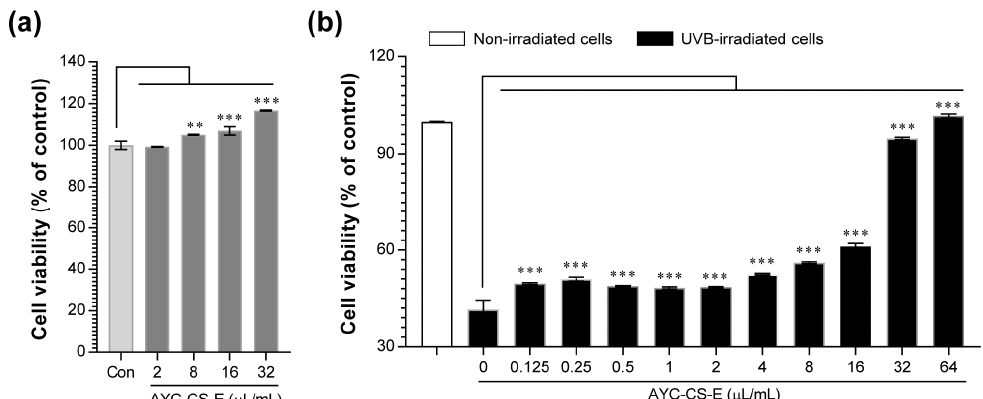
described in the Materials and Methods section. The cell viability for each condition was measured using the MTT assay. All bar graphs show the means ± standard deviation (SD) of 3 samples. One representative plot out of three independent experiments is shown. ** p < 0.01, and *** p < 0.001.